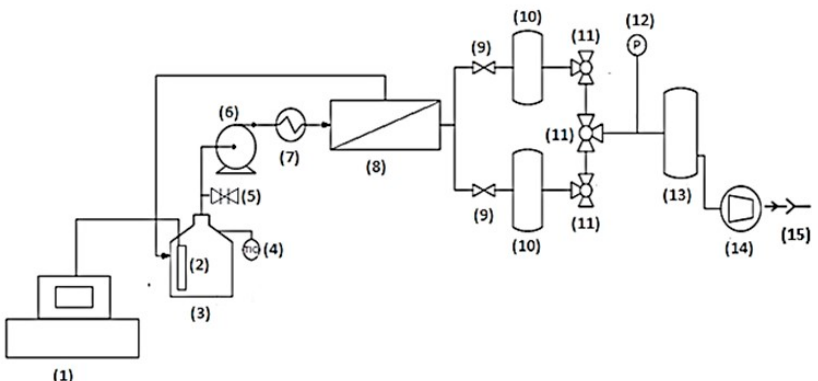
Figure 1. Pervaporation process set-up: ( 1 ) NIR Spectrometer with an acquisition software; ( 2 ) NIR probe; ( 3 ) Feed tank (5 L); ( 4 ) Temperature sensor ( ± 0.2 °C from − 30 to 120 °C); ( 5 ) Filing valve; ( 6 ) Volumetric pump (400 L h − 1 ); ( 7 ) Heat exchanger; ( 8 ) Membrane; ( 9 ) Simple valve; ( 10 ) Cold traps with liquid nitrogen (1 L); ( 11 ) 3-way valves; ( 12 ) Vacuum pump sensor (< ± 10% from 10 − 2 to 20 mbar); ( 13 ) Fail-safe cold trap (1 L); ( 14 ) Vacuum pump; ( 15 ) Air